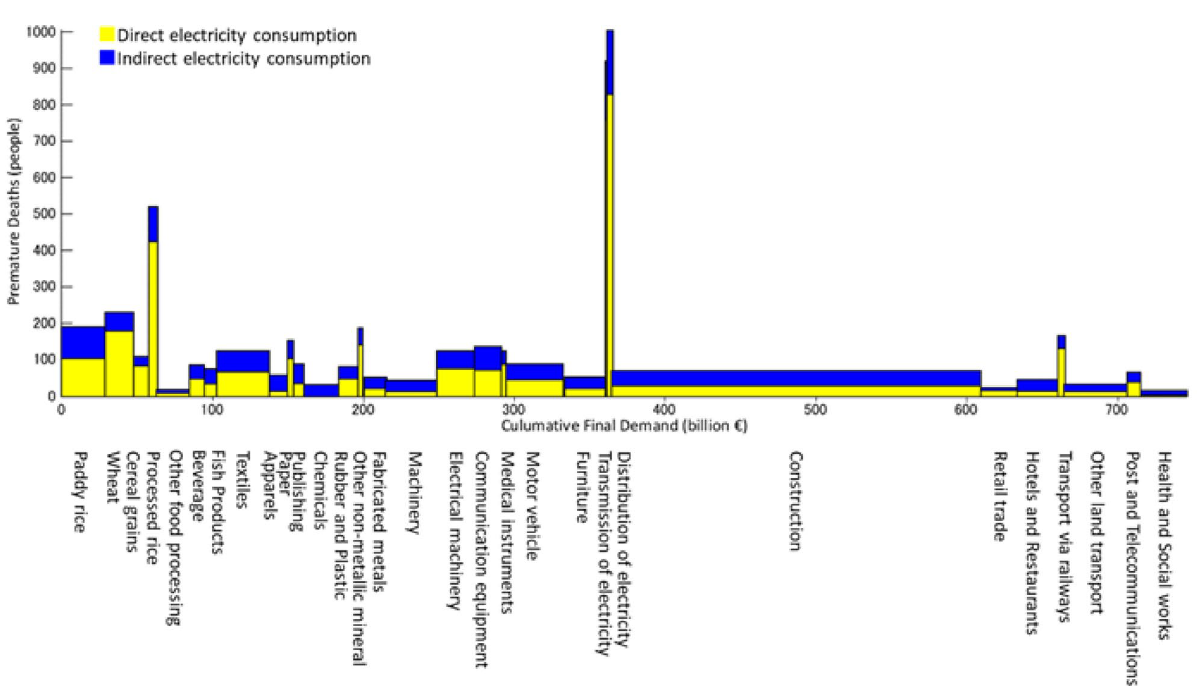
Figure 2. Contribution of electricity consumption by India’s domestic sectors to health